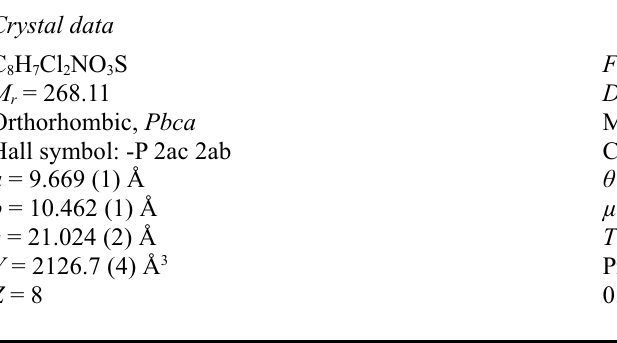
Figure 2 View of the molecular packing in (I) with hydrogen bonding shown as dashed lines. 2,2-Dichloro- N